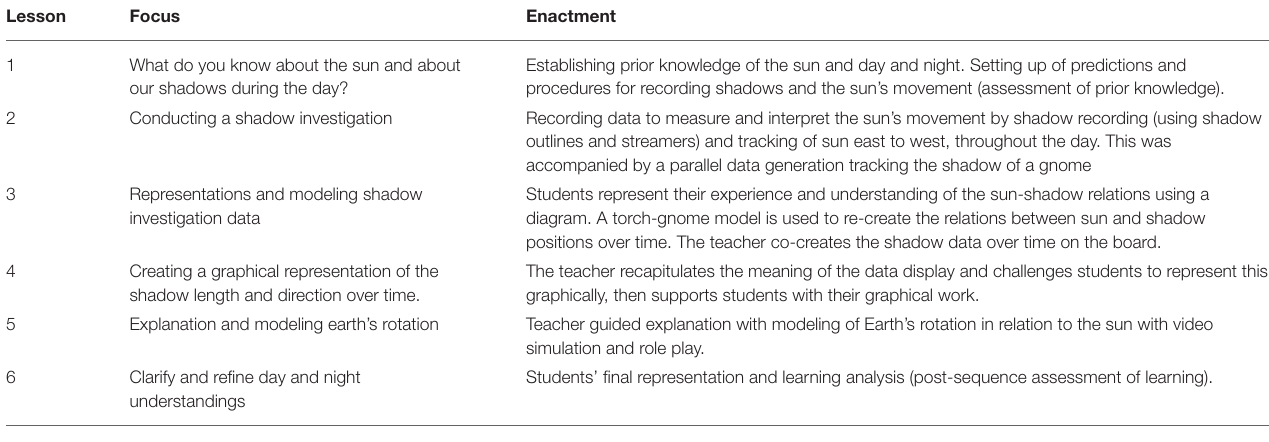
TABLE 1 | Astronomy learning sequence. Lesson